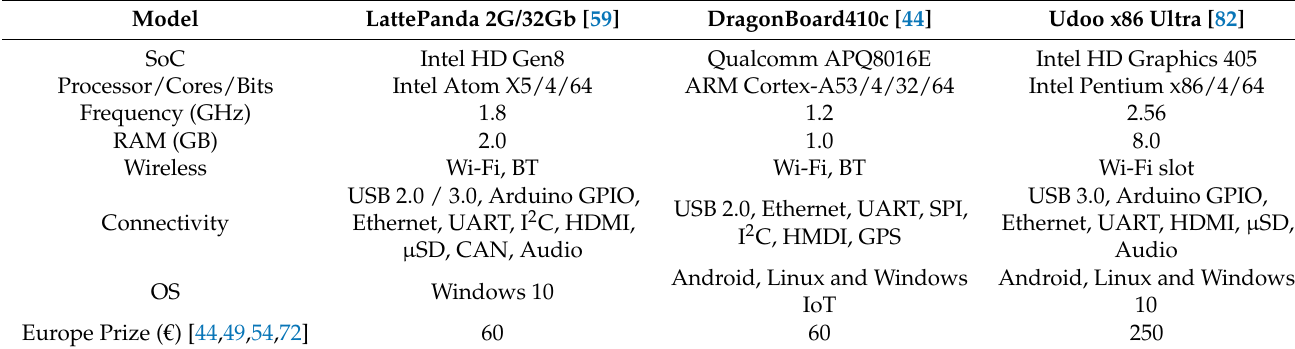
Table 5. Main open-source SBCs Windows based in the